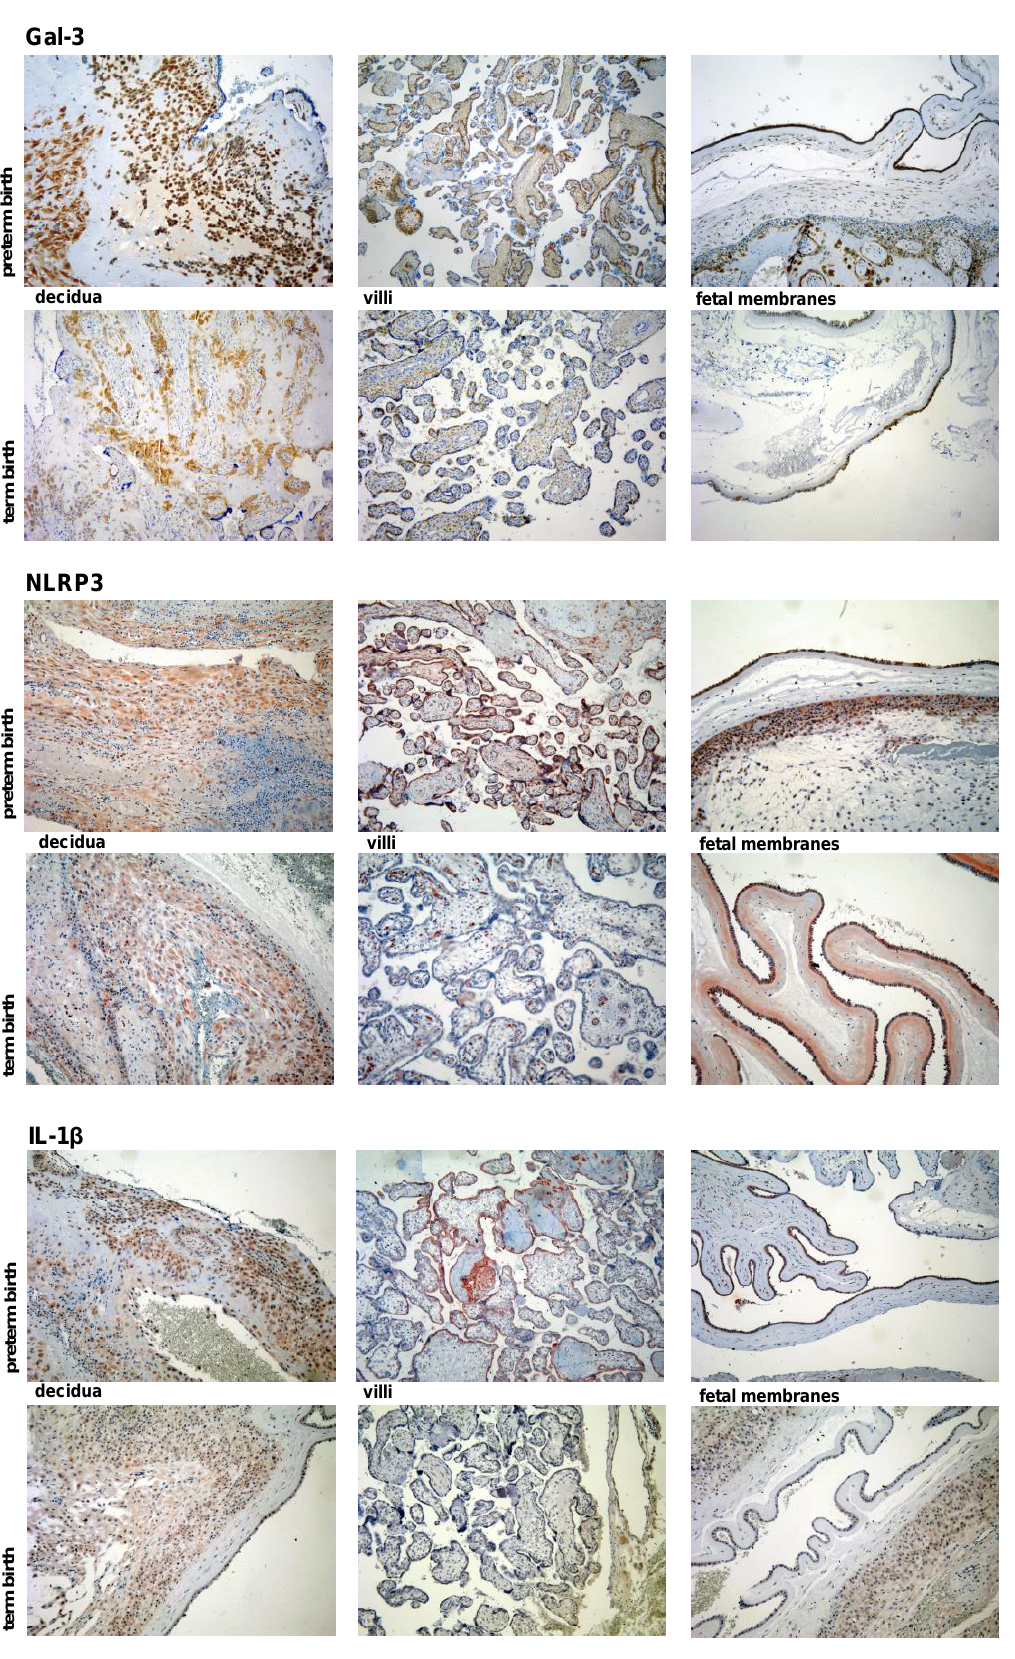
Figure 4. Representative sections of Gal-3, IL-1 β , and NLRP3 immunohistochemistry of decidua, villi and fetal membranes tissues obtained during preterm and term births (magnification 100×).